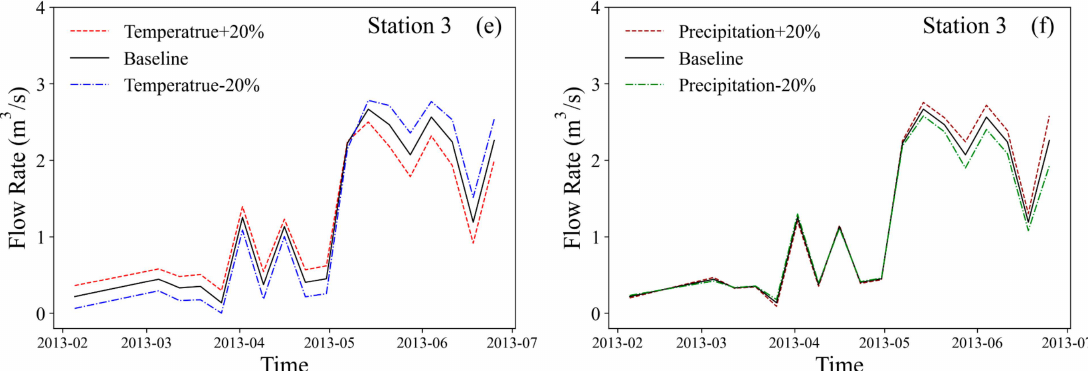
Figure 6. Changes in drainage flow rates in response to variations in temperature and total pre- cipitation. ( a ) Temperature sensitivity test for Station 1; ( b ) Precipitation sensitivity test for Sta- tion 1; ( c ) Temperature sensitivity test for Station 2; ( d ) Precipitation sensitivity test for Station 2; ( e ) Temperature sensitivity test for Station 3; ( f ) Precipitation sensitivity test for Station